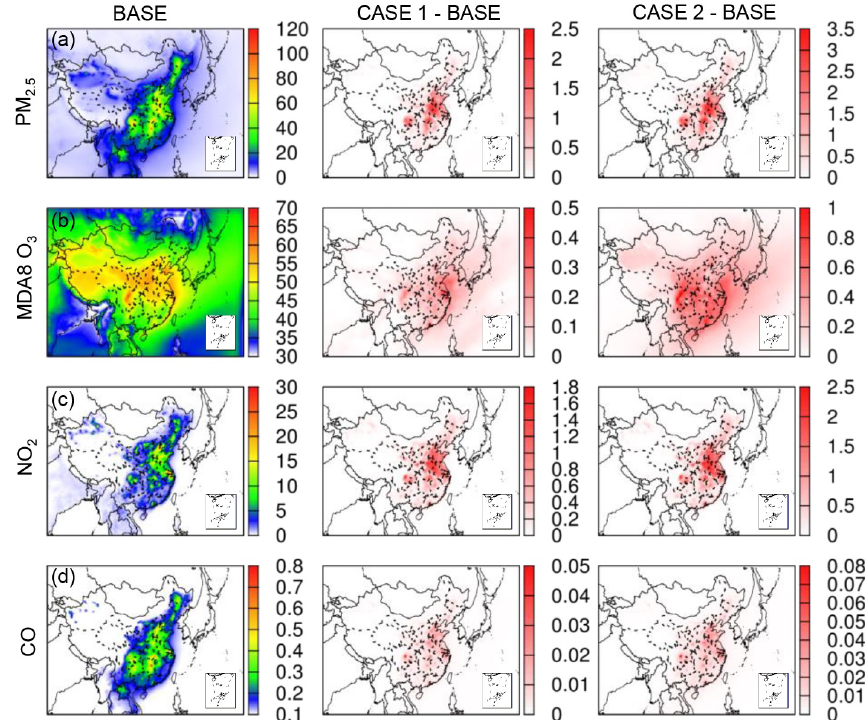
Figure 2. The annual average concentrations of (a) PM 2 . 5 , (b) MDA8 O 3 , (c) NO 2 and (d) CO of BASE case, as well as their differences from CASE 1 and CASE 2 in 2020. The unit for PM 2 . 5 is micrograms per cubic meter (µgm − 3 ), for MDA8 O 3 and NO 2 parts per billion (ppb), and for CO parts per million